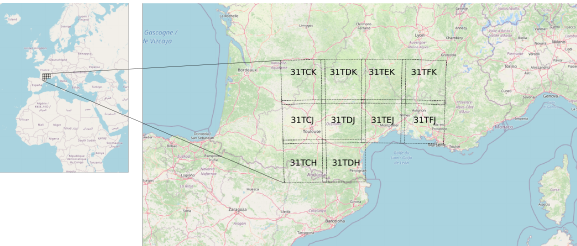
Figure 1. The region of interest, located in the Occitanie area (south of France mainland). Sentinel-2 images envelopes are plotted in black. Map data © OpenStreetMap contributors, CC BY-SA